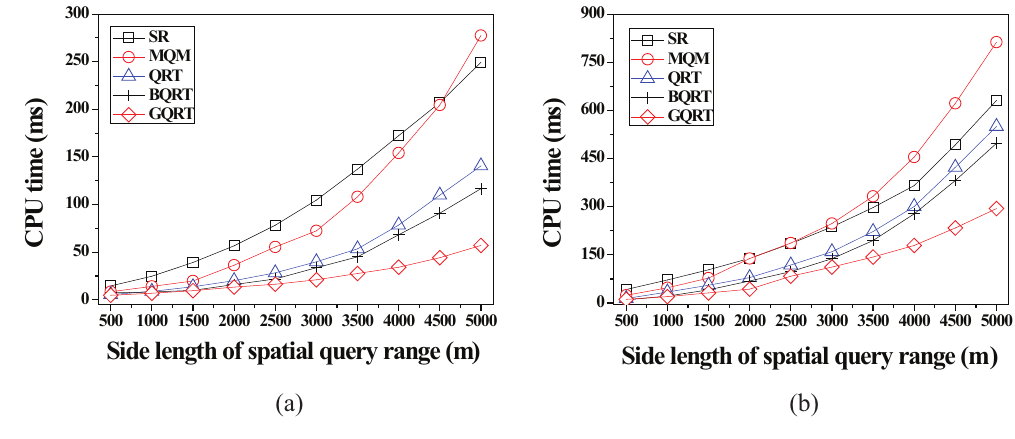
Figure 10. CPU-time vs . size of spatial query ranges. ( a ) Uniform ; ( b ) Skewed